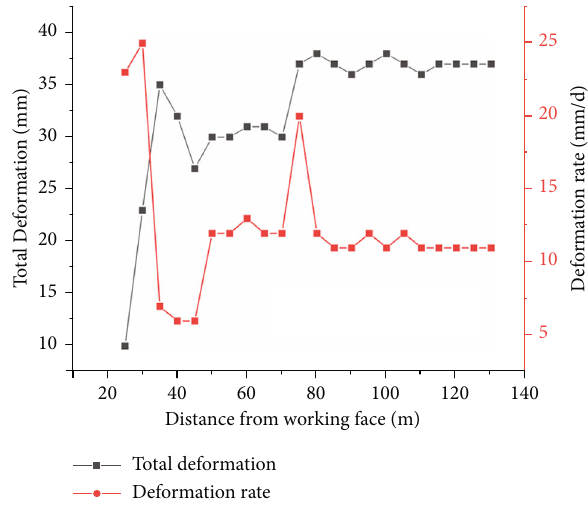
Figure 10: Deformation curve of two sides of 24207 gob-side entry retaining.